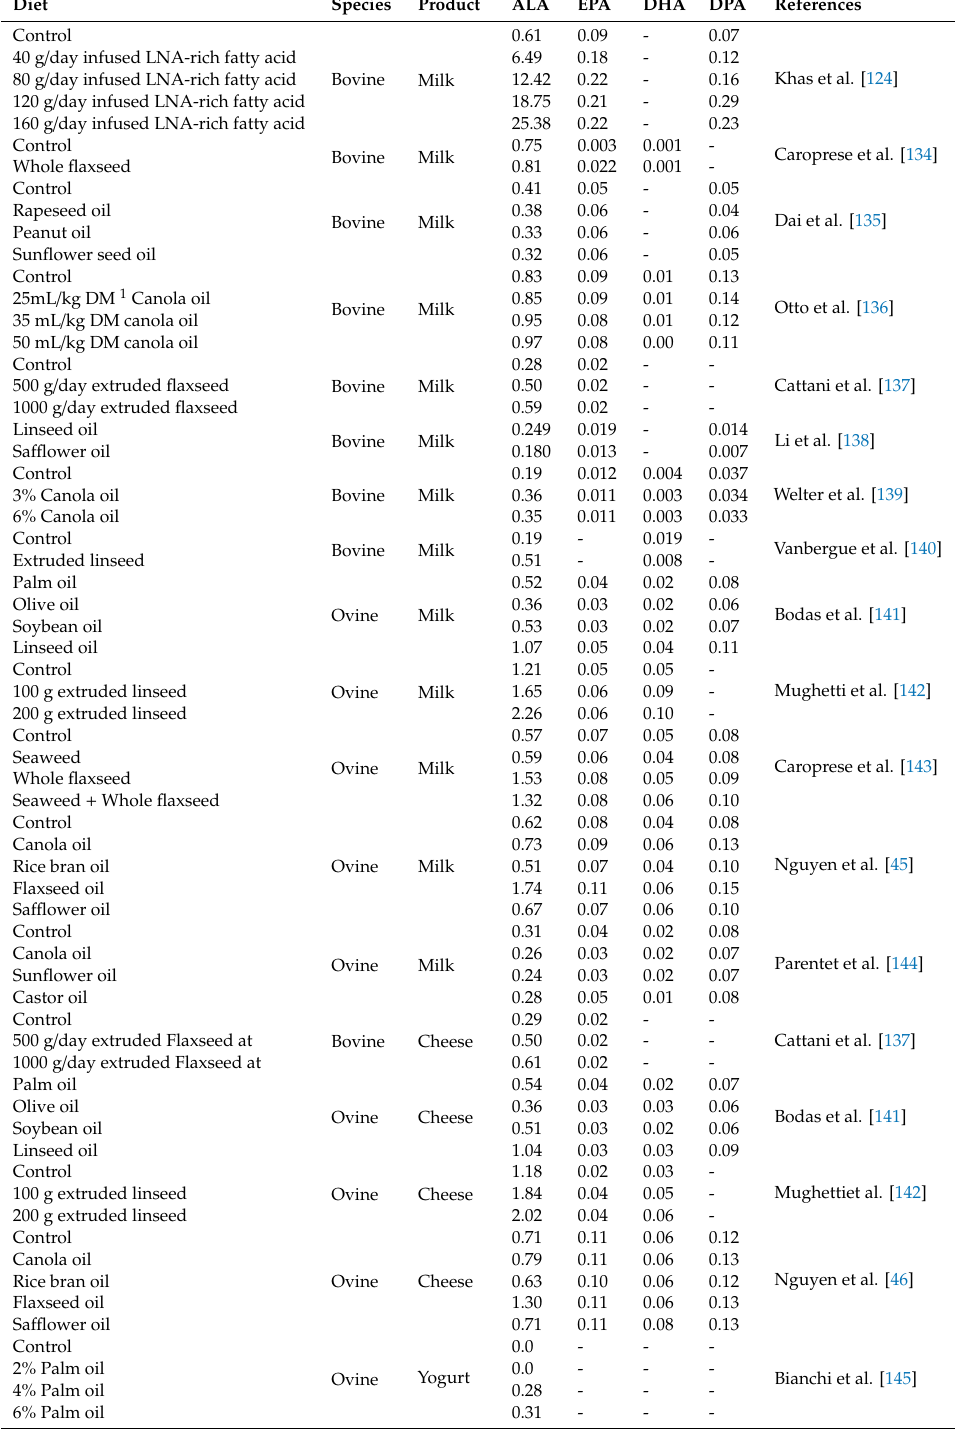
Table 4. E ff ect of supplementing ruminants with plant-derived dietary sources on n-3 PUFA concentration in milk and milk products (g / 100 g fatty